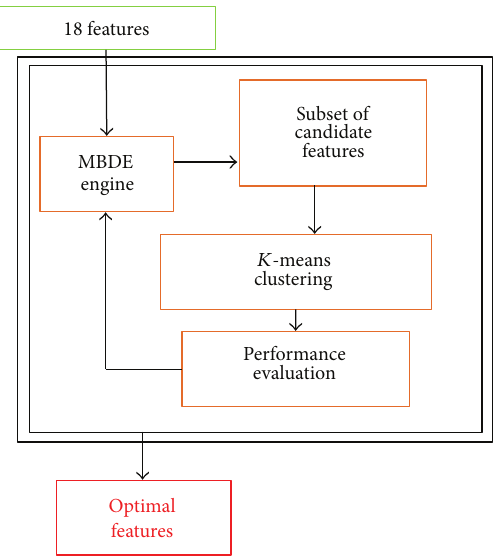
Figure 12: Wrapper approach for optimal feature subset selection based on a MBDE optimization algorithm and a 𝐾 -means